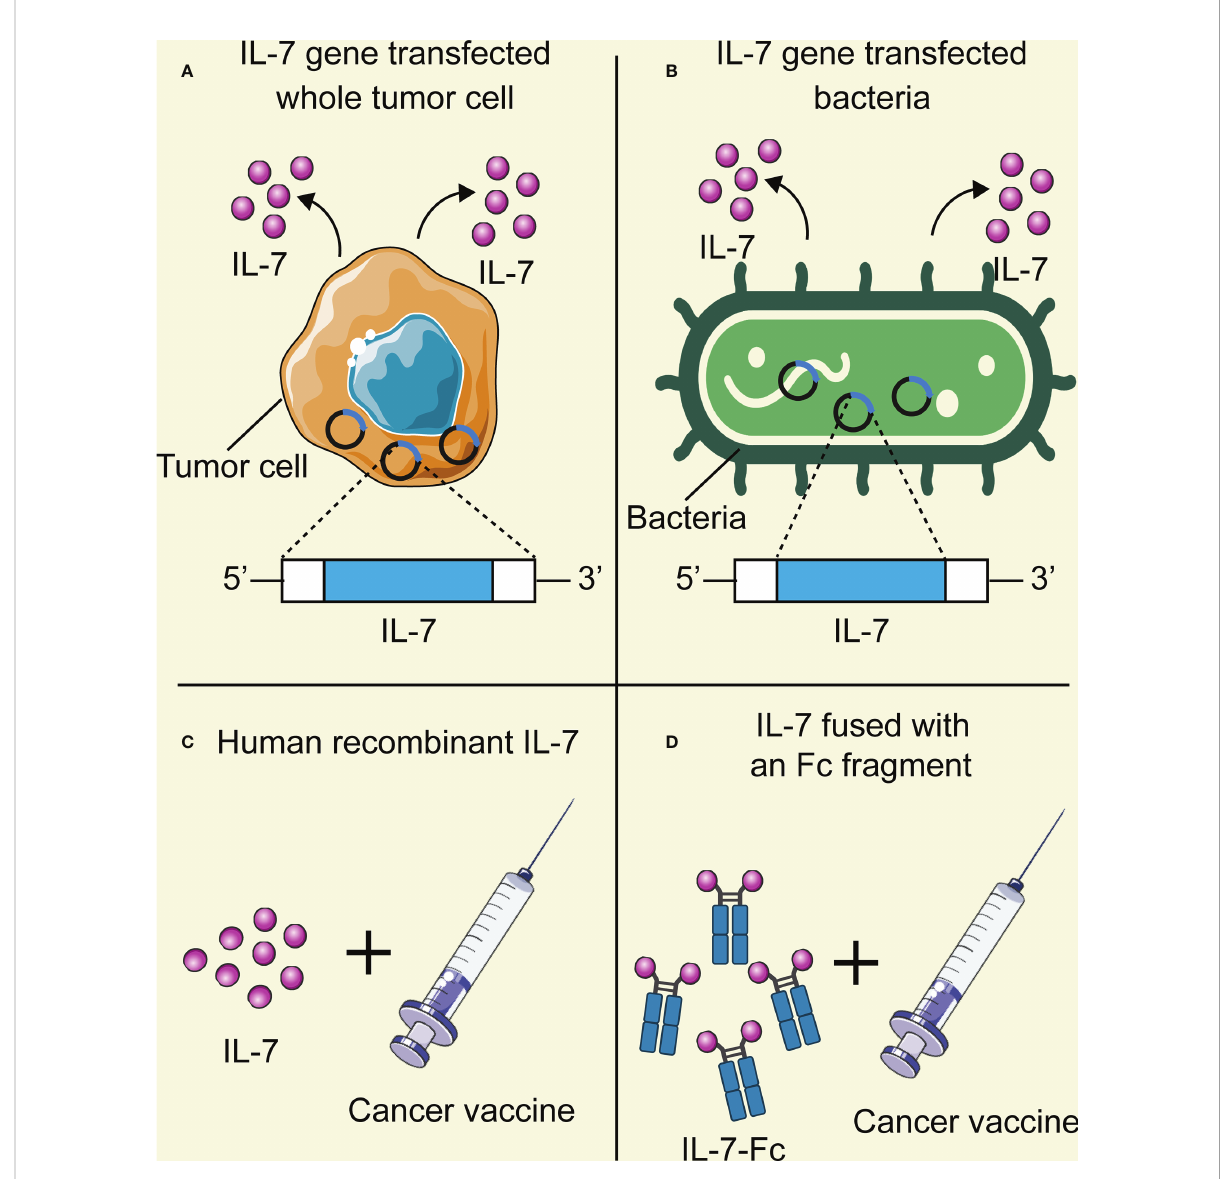
FIGURE 4 The adjuvant platform of IL-7 for cancer vaccines in preclinical and clinical trials. (A) Cancer vaccine tumor cells are transfected with the adjuvant IL-7 gene and then produce IL-7 stably. (B) Bacteria are transfected with the adjuvant IL-7 gene and then produce IL-7 stably. (C) Direct administration of human recombinant IL-7 as an adjuvant in combination with cancer vaccines. (D) IL-7 fused with the Fc region of the antibody as an adjuvant. This fi gure is created with BioRender.com and